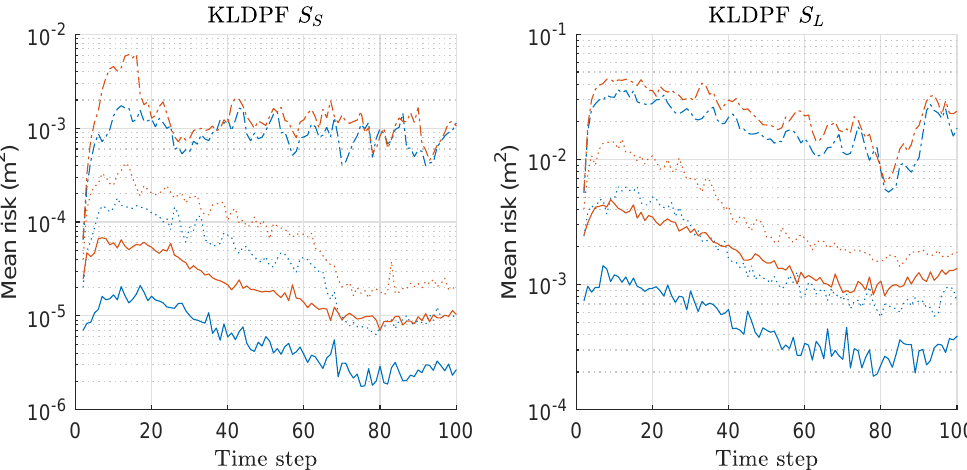
Figure 11. Mean-risk over 300 runs with 1000 particles based on Equation (20) for KLDPF and MKLDPF. Results regarding only r x are shown, and those regarding r y showed similar results. Legend: line style (dash-dot: M = 2; dotted: M = 5; solid: M = 10); (line color: blue: KLDPF; red: MKLDPF).